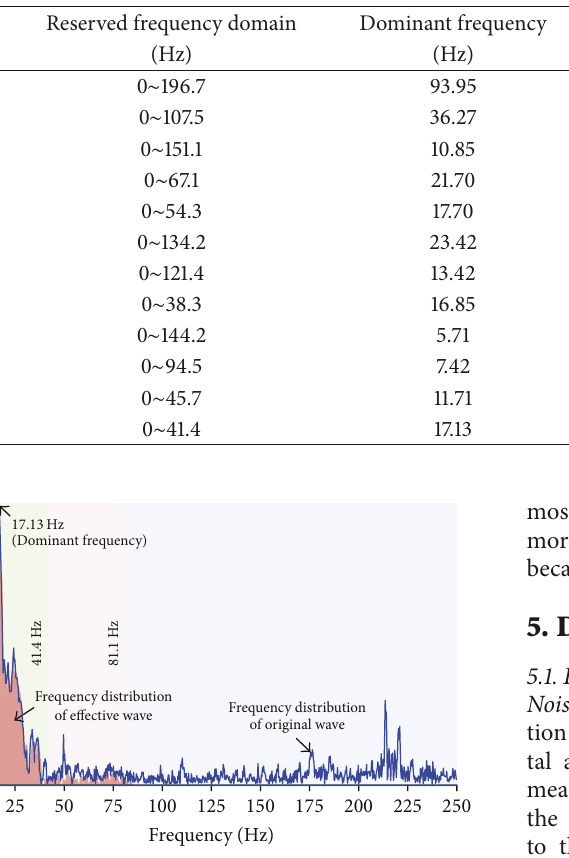
Table 3: Acceptable frequency domain and variation of the dominant parameters of the extracted effective microseismic waves in all of the monitoring channels.